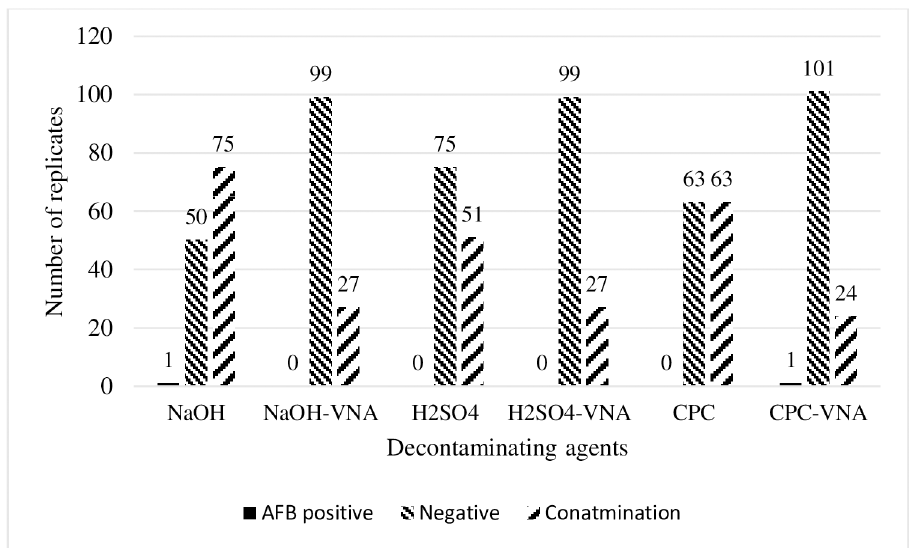
Fig 4. Number of tubes showing growth of mycobacteria recovered from field avian fecal samples using different decontamination procedures. Incorporation of VNA minimized the contamination of cultures in all procedures. However, VNA in NaOH significantly reduced the proportion of contaminated cultures (59.5%; χ 2 test p = 0.0001) and CPC (50%; χ 2 test p =